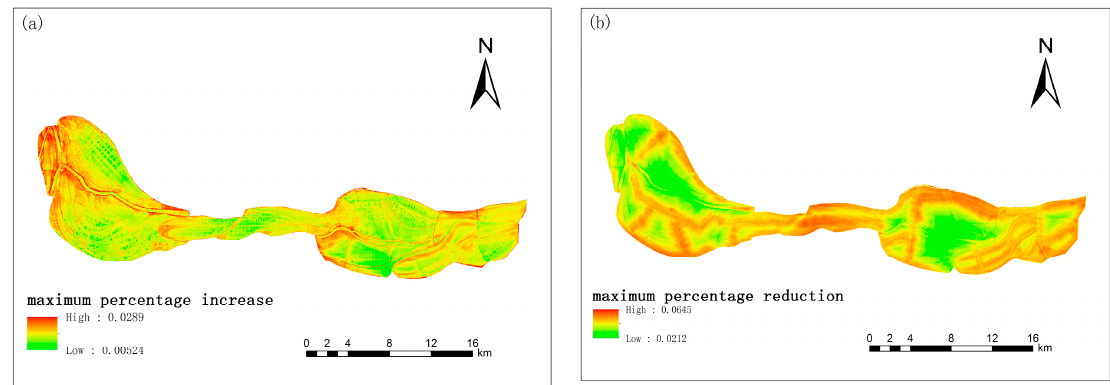
Figure 14. Ranking map of flood hazard risk (FHR) indicators and the impact map on assessment results. ( a ) maximum percentage increase and ( b ) maximum percentage reduction.